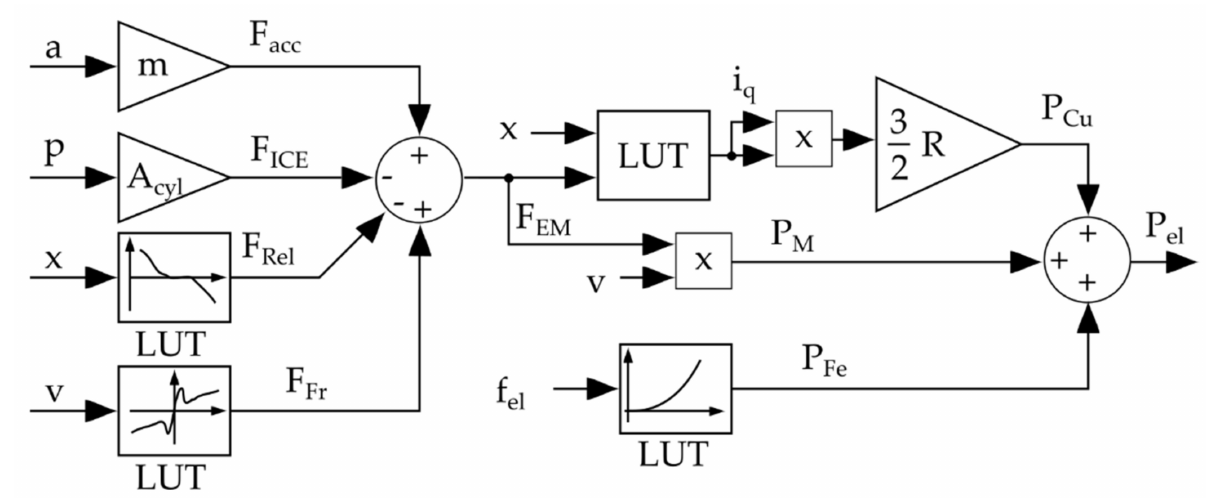
Figure 8. Simplified simulation model of the